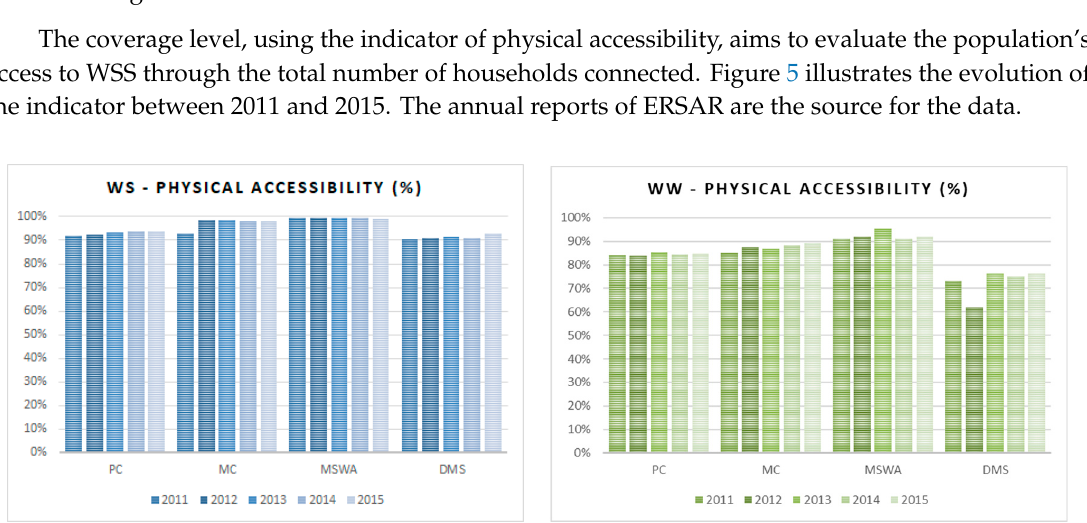
Figure 5. Evolution of coverage levels in water (left) and wastewater services (right).